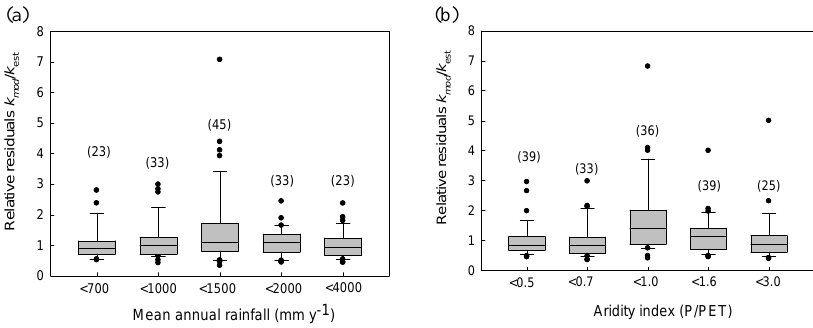
Fig. 7. Scatter plot of relative residuals (ratio of modelled to hydrograph-based estimated k bf ) versus (a) rainfall weighted slope of catchment (SLO) and (b) catchment elongation (CE). Elongated ellipses around Malaysian and Senegal data points are shown to illustrate possible correlations of residuals at smaller scales for geographically close catchments.